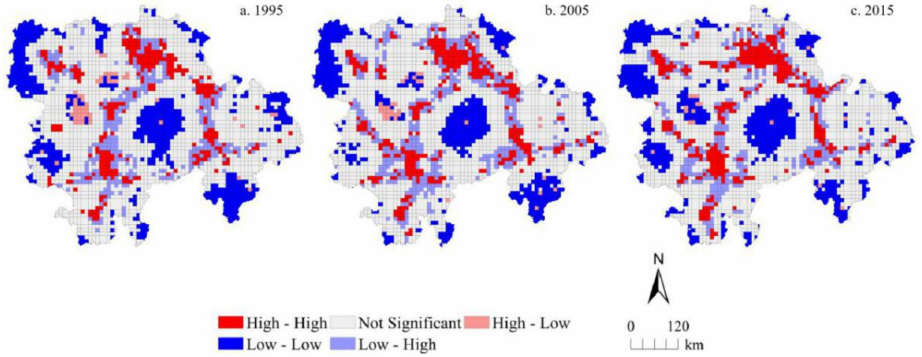
Figure 7. Bivariate LISA cluster maps showing urbanization level and traffic accessibility in the Middle Reaches of the Yangtze River Urban Agglomerations at 10 km gride